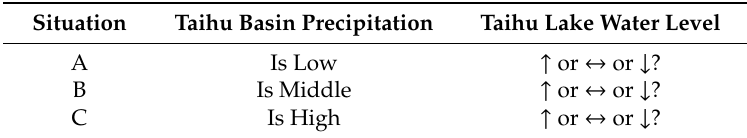
Table 10. Situation-setting of precipitation in the typhoon period.